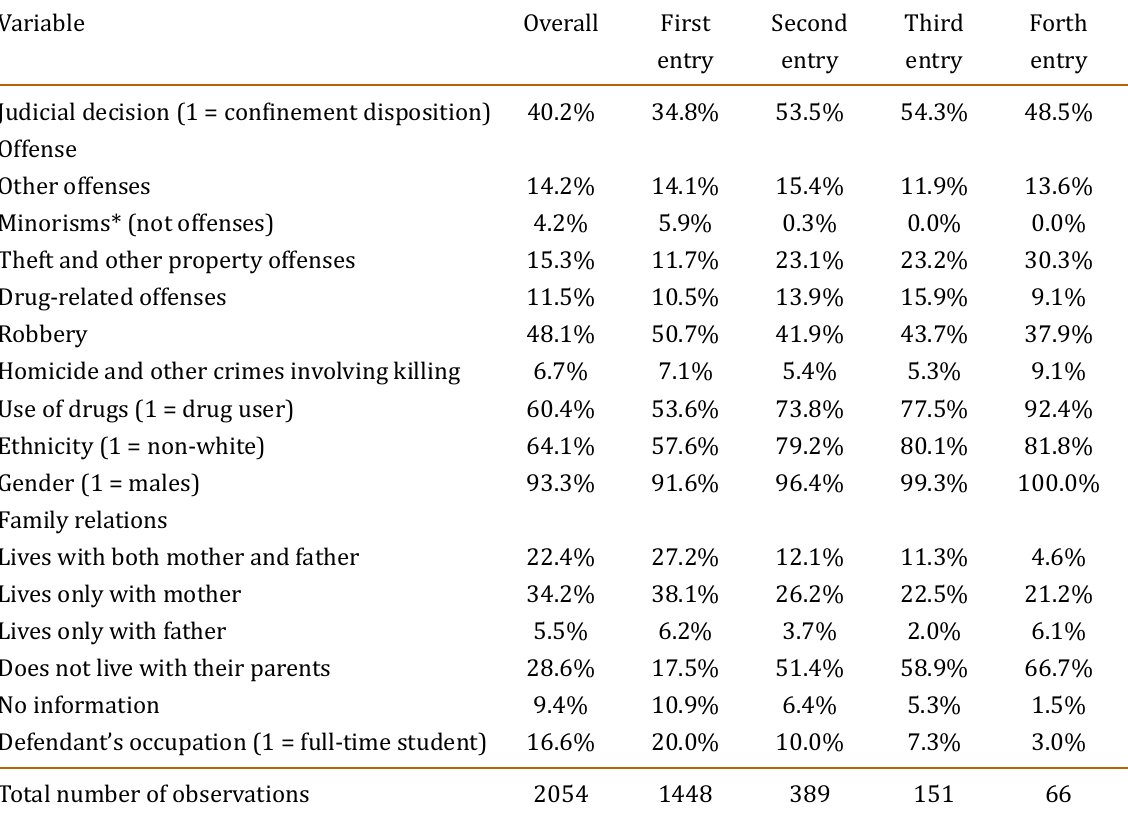
Table 1: Distribution of adolescents by entry into the juvenile justice system